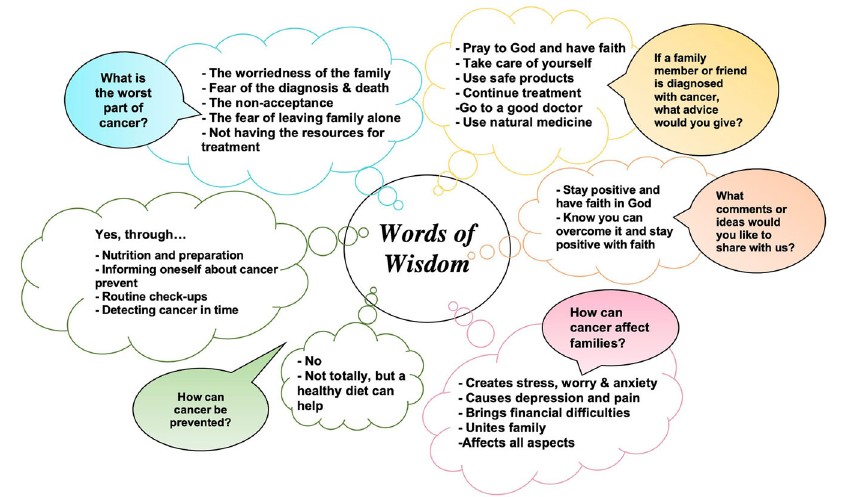
Fig. 1 Advice and words